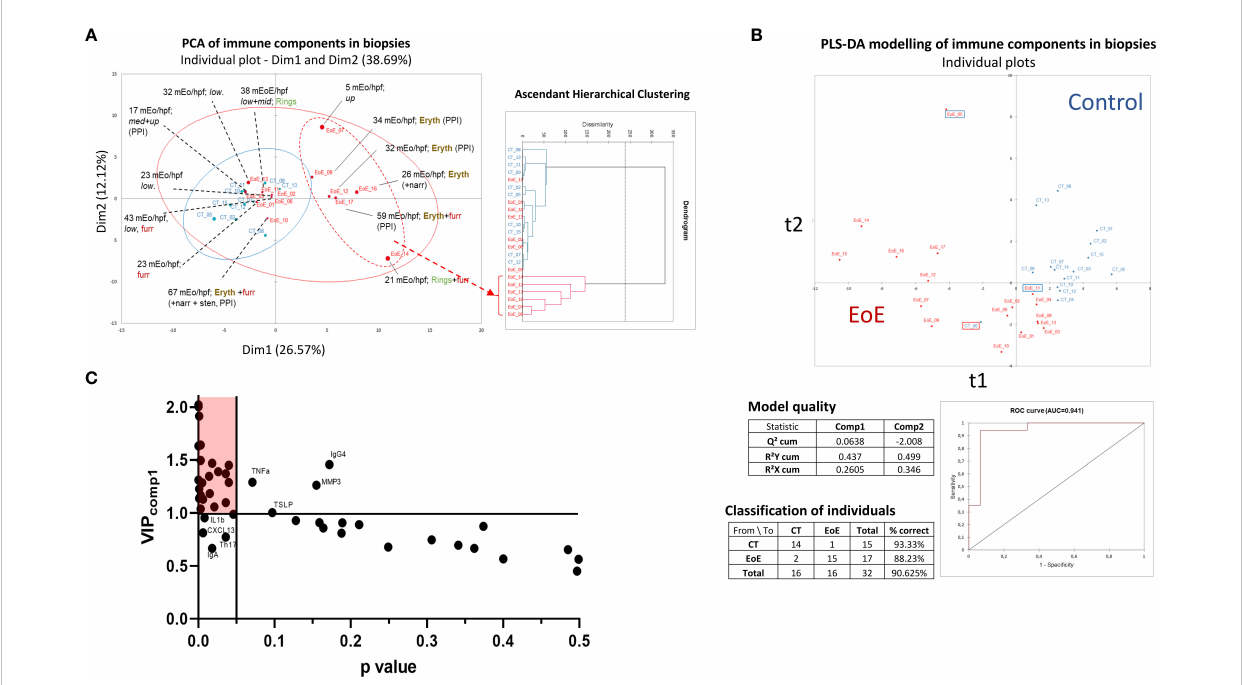
FIGURE 2 Non-supervised and supervised analysis of cellular and soluble immune constituents in oesophageal biopsies. (A) Non-supervised ACP (left) and AHC (right) analysis of all data obtained from EoE patients (red, n = 13 of 17; four have to be excluded from ACP due to missing values) and CT (blue, n = 10 of 15; fi ve excluded due to missing values). Endoscopy observations (erythema: eryth, furrows: furr, rings, narrowing and/or stenosis) and mean eosinophil counts (mEo/hpf) obtained from the three analysed biopsies (upper, middle, and lower third) are indicated for each EoE patient. For some patients, EoE was restricted to the upper (up), middle (mid), and/or lower (low) third part of the oesophagus as indicated. (B) PLS-DA modelling constructed with all immune data available (missing values are ignored) from the 17 EoE patients (red) and 15 controls (blue), and model